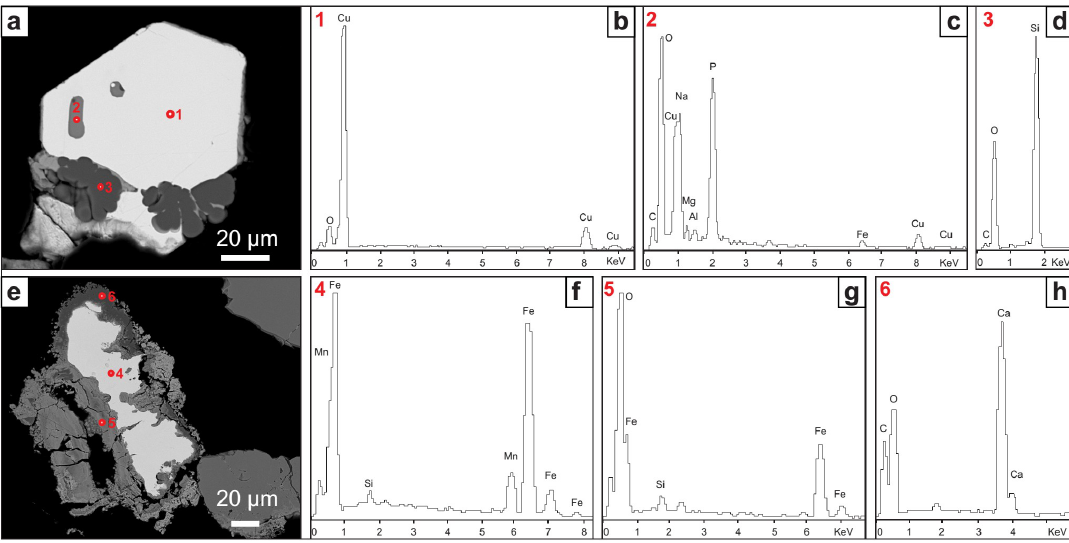
Figure 8. Metallic alloys found in the mineral concentrates of chromitite samples: ( a ) Backscattered electron (BSE) image of a metallic grain showing inclusions and mineral growth in the lower border.